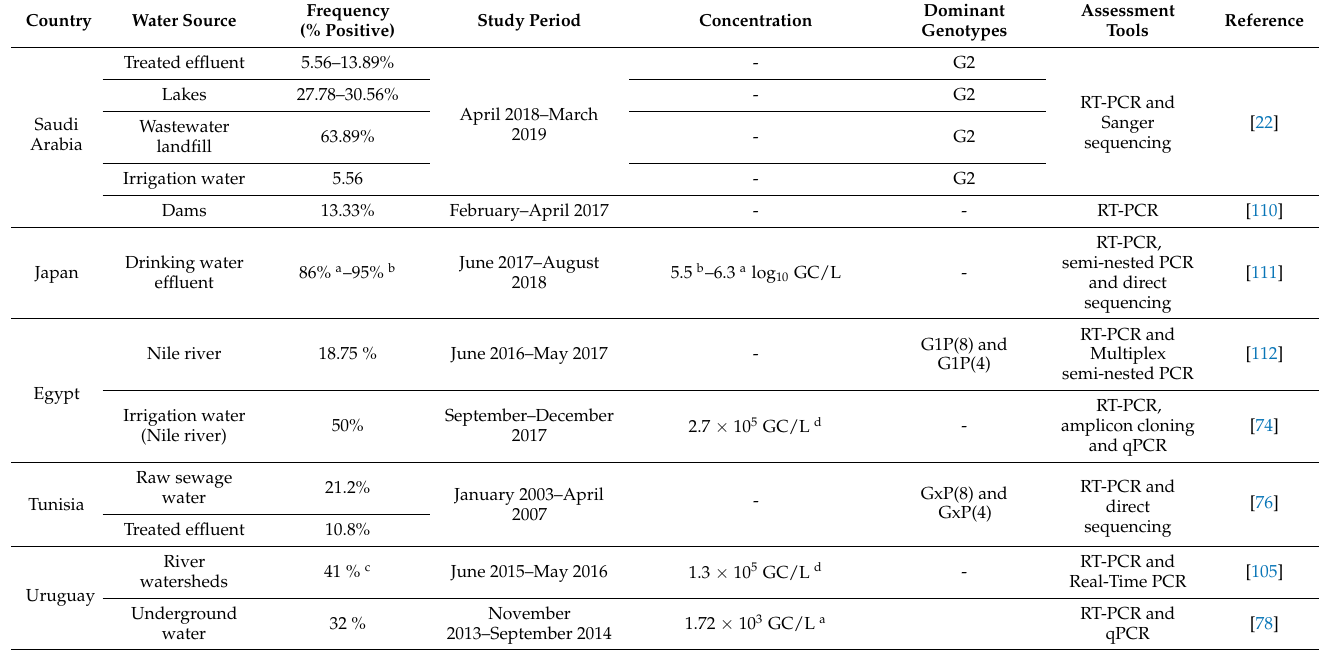
Table 2. Rotavirus frequency and dominant genotypes in different water